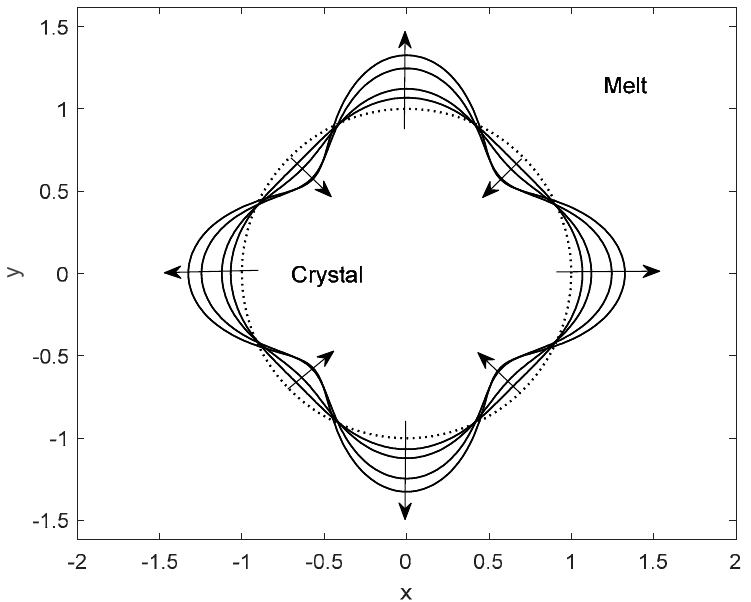
Figure 1. The cross-sectional curves of the interface morphology of the columnar crystal under the influence of anisotropic interface energy at different times t = 0,0.05,0.10,0.30,0.60, where α 4 = 0.25, r 0 = 1.1 R ∗ , Γ = 0.4545, and ∆ T = 10. By contrast, the dashed line denotes the columnar crystal without the anisotropic effect of interface energy. Arrows indicate crystal growth trends.